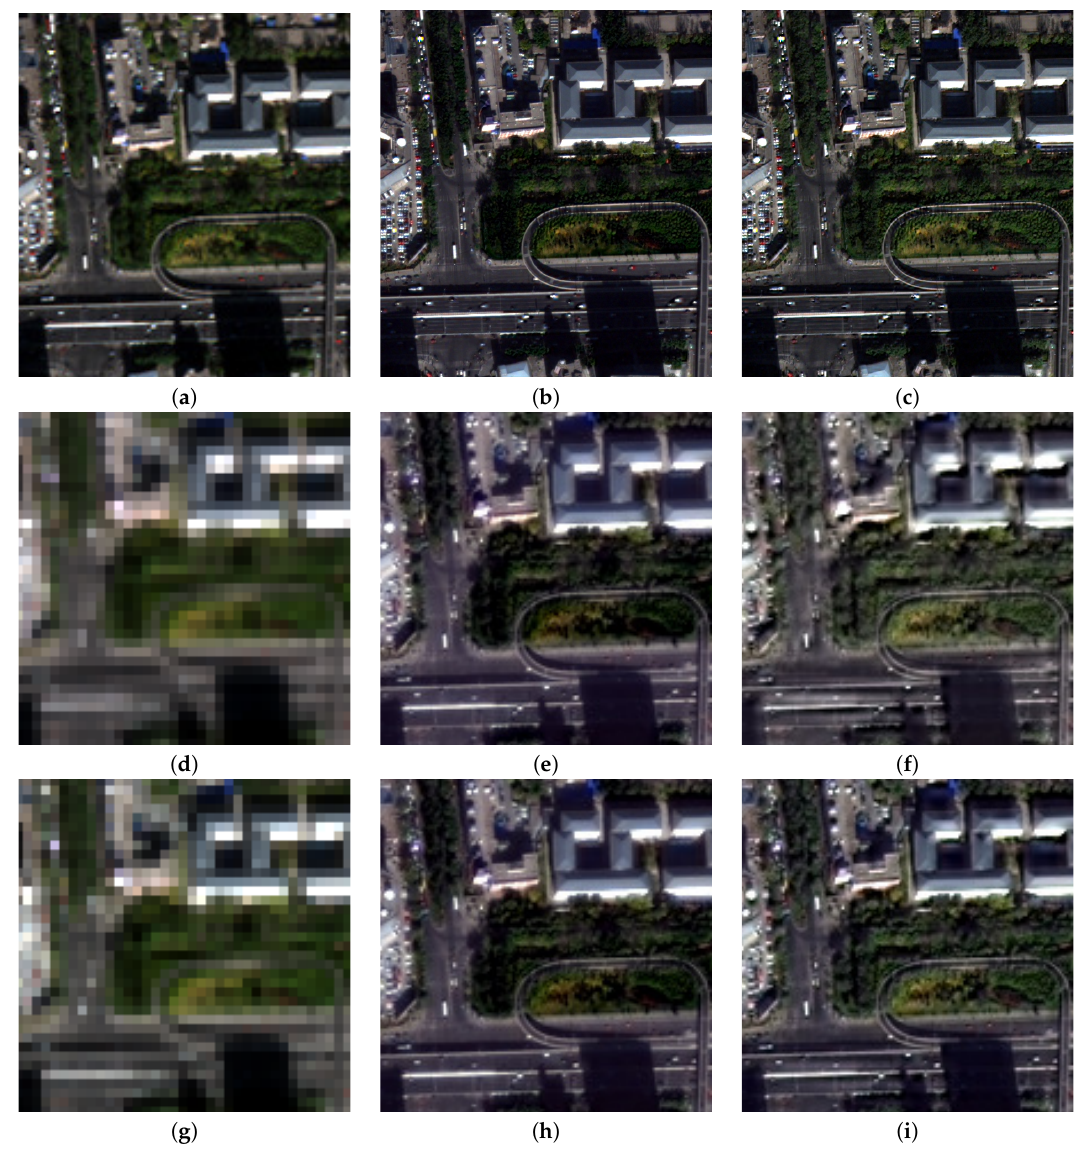
Figure 6. ( a ) Original multispectral (MS) image; ( b ) Fusion result of GS at full scale; ( c ) Fusion result of Indusion at full scale; ( d ) Degraded MS image by Aiazzi’s method; ( e ) Fusion result of ( d ) by GS; ( f ) Fusion result of ( d ) by Indusion; ( g ) Degraded MS image by MSD4FV; ( h ) Fusion result of ( g ) by GS; ( i ) Fusion result of ( g ) by